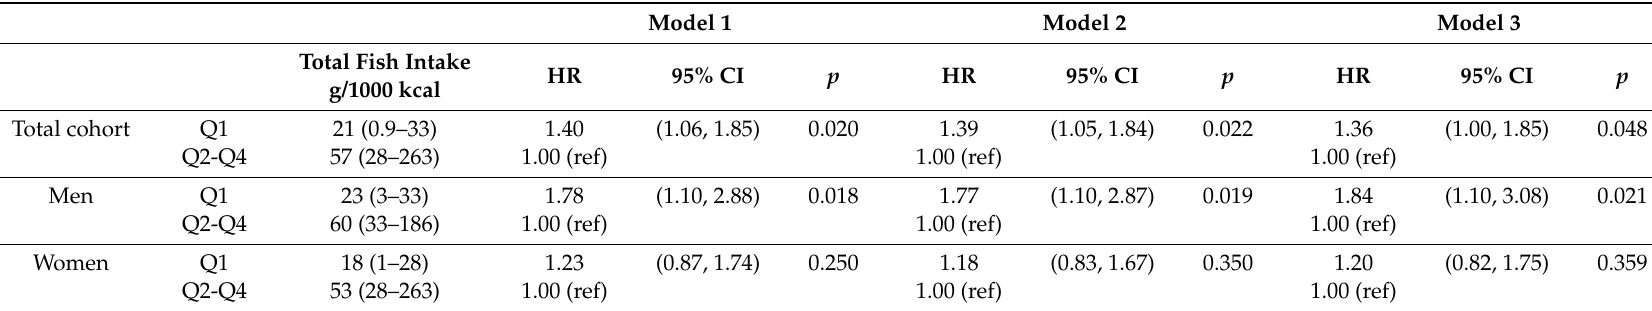
Table 4. Cox proportional hazards regression analysis of risk of hip fracture according to total fish intake comparing Q1 to Q2–Q4 for the total cohort ( n = 2865), men ( n = 1315), and women ( n = 1548) from the Hordaland Health Study followed from inclusion in 1997–1999 (age 71–74 years) until 31 December